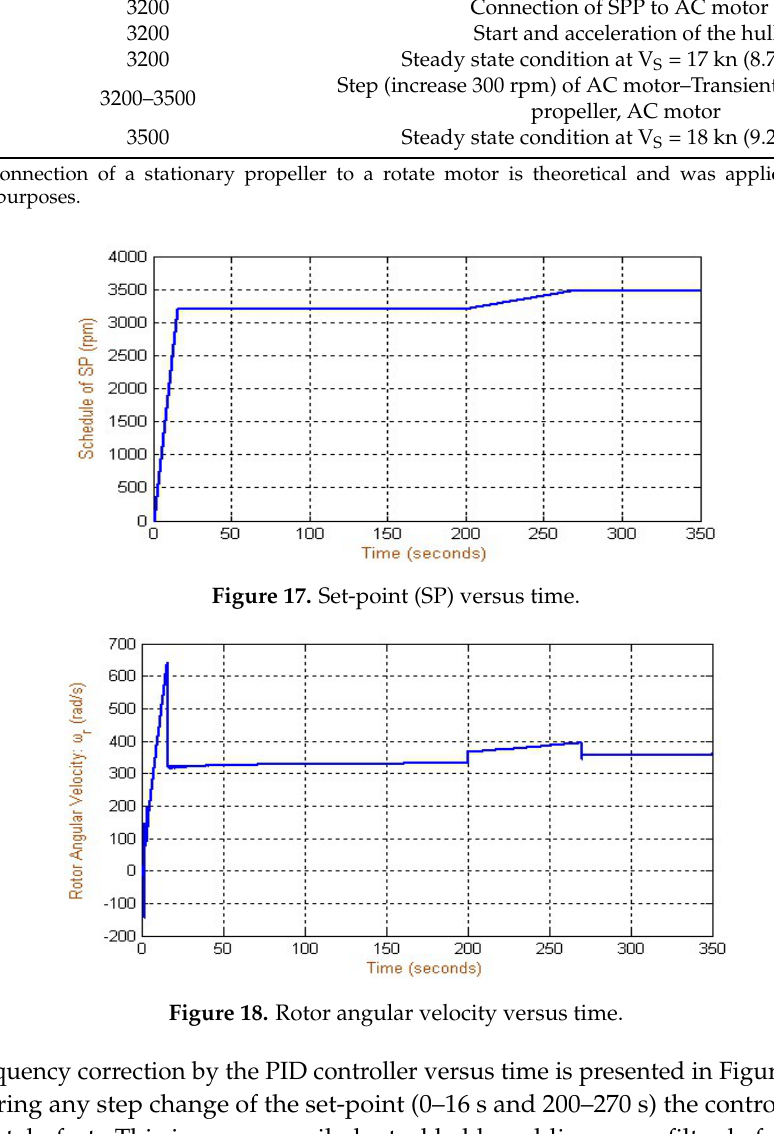
Figure 19. PID drive frequency correction versus time.